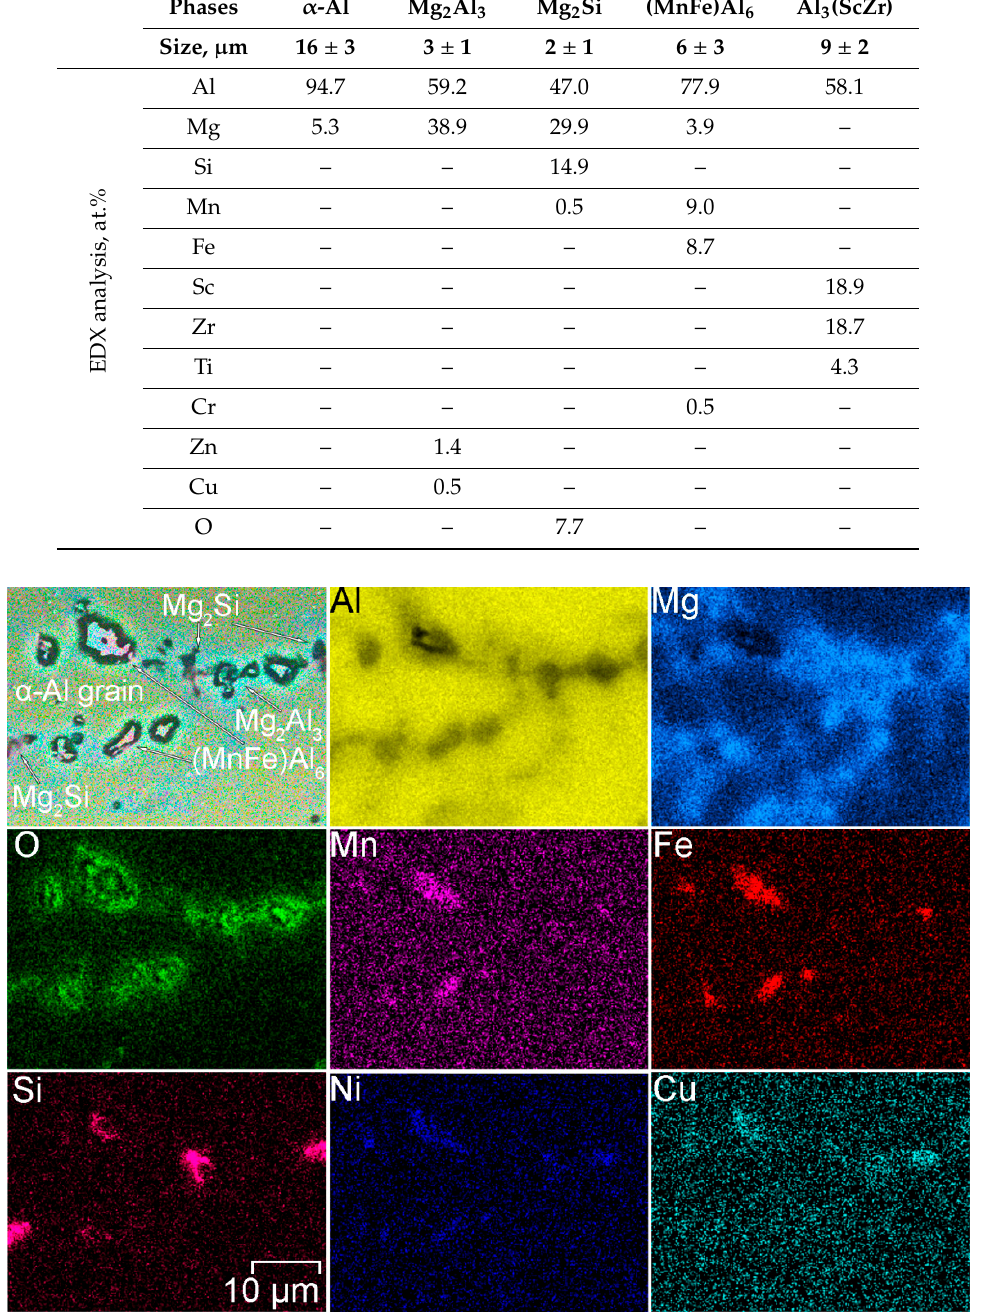
Figure 10. SEM-EDX analysis of the corrosion-active area in the HAZ after 1.5 h immersion in 3% NaCl.